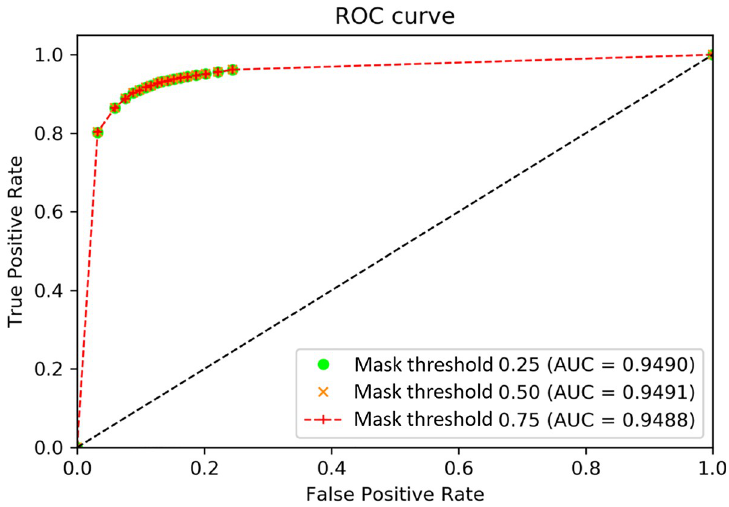
Fig 7. Receiver operating characteristic curve of lesion detection inference for all tumor densities.